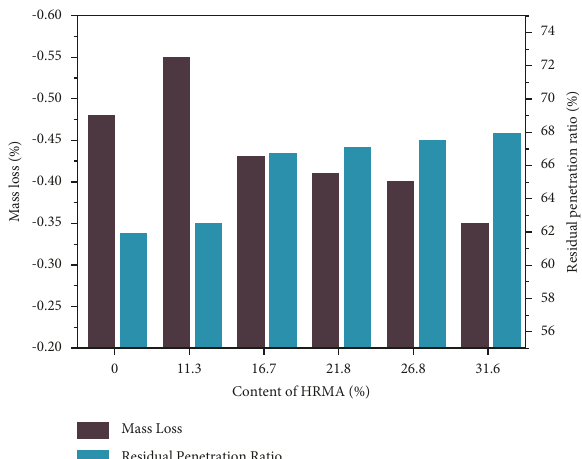
Figure 9: Variation of RTFO aged modified asphalt with HRMA content.